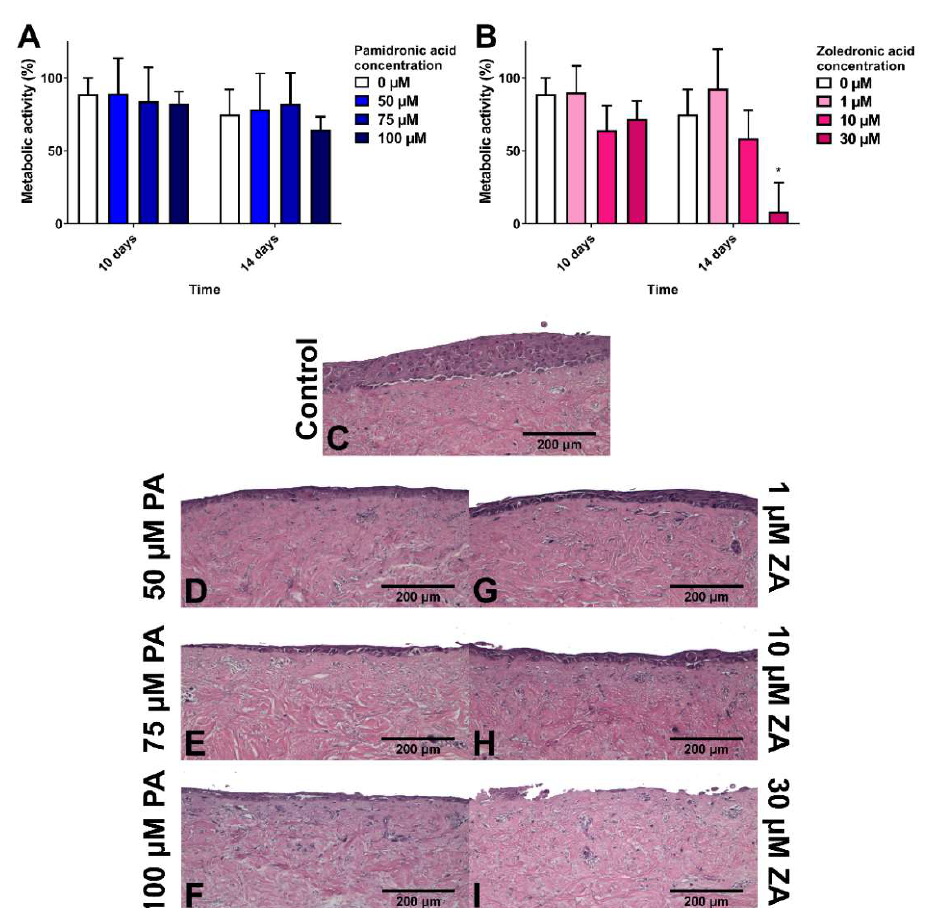
Figure 3. The metabolic activity of oral mucosa models when treated with ( A ) pamidronic acid and ( B ) zoledronic acid for 7 days after prior culture at ALI in control medium for 7 days, measured with a resazurin assay. A blank well reading was subtracted before values were normalised to day 7 value for each model, defining day 7 values as 100 % (not shown). N = 3, n = 3. Error bars = SD. Statistical significance against 0 µ M at each time point indicated by * p ≤ 0.05. ( C – I ) H & E-stained sections of oral mucosa models seeded with human oral fibroblasts and immortalised human oral keratinocytes cultured at ALI for 7 days in control medium, then treated with ( C ) control medium; ( D ) 50 µ M, ( E ) 75 µ M and ( F ) 50 µ M pamidronic acid; ( G ) 1 µ M, ( H ) 10 µ M and ( I ) 30 µ M zoledronic acid, respectively, for 7 days. Representative images used.